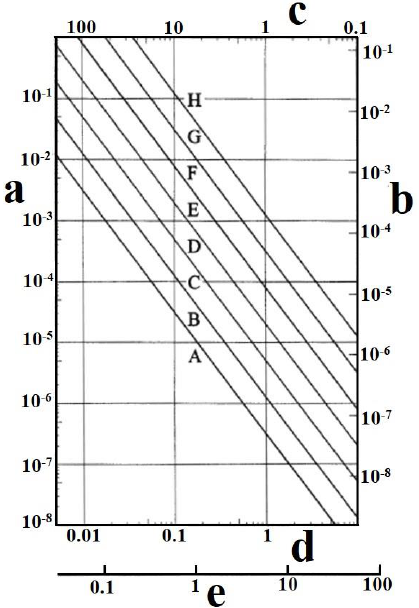
Figure 7. Power spectral densities of random road roughness profiles according to the ISO classifi- cation (based on [27,28]): from A to H. Two-logarithmic scale. The meaning of the lowercase letters in the picture: a — power spectral density S d (1/L) [m 3 ]; b — power spectral density S d ( Ω ) [m 3 /rad]; c — wavelength L [m]; d — wavenumber 1/L [1/m]; e — angular wave number of the road (i.e., angular road frequency) Ω = 2 π /L [rad/m].